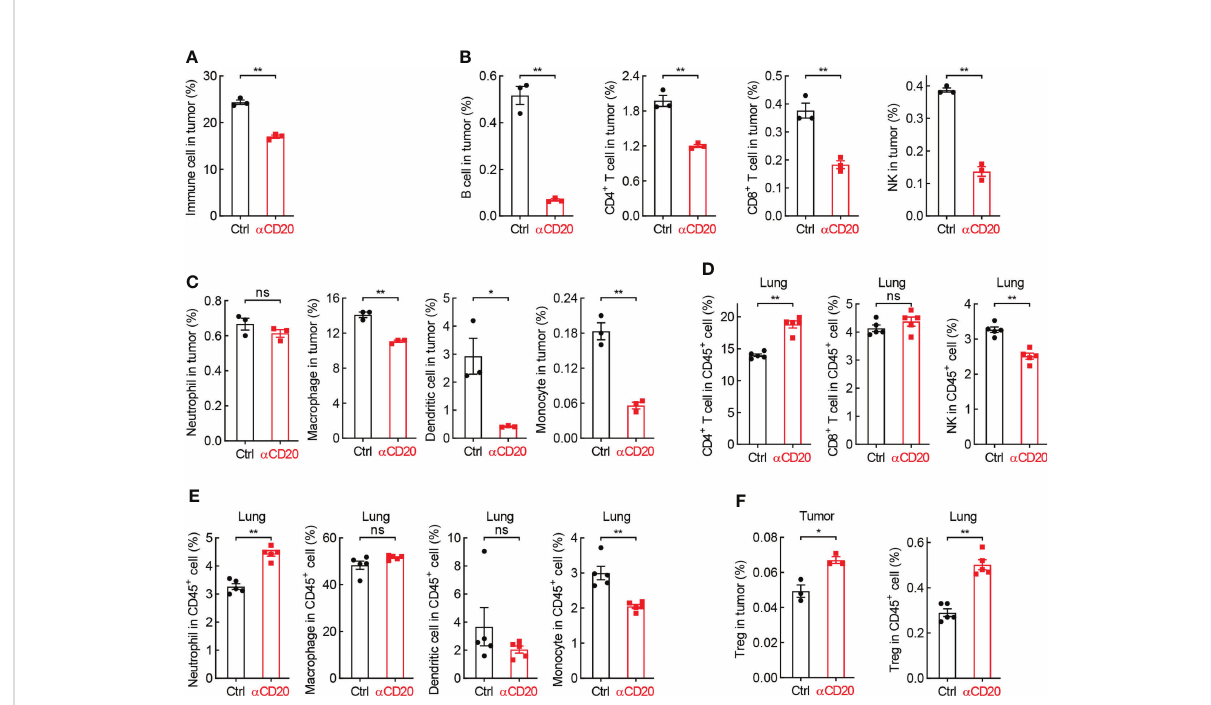
FIGURE 5 B cell deprivation dampens tumor in fi ltration of immune cells in lung cancer. (A) FACS data showing reduced abundance of immune cells in tumor from mice with a CD20-mediated B cell depletion (n = 3). (B, C) FACS data showing decreased tumor-in fi ltrating lymphocytes (B) and myeloid cells (C) by a CD20-mediated B cell depletion (n = 3). (D, E) FACS data showing differential changes of lymphocytes (D) and myeloid cells (E) in lung tissue by a CD20-mediated B cell depletion (n = 5). (F) FACS data showing augmented Treg cell frequency in both lung tumor (n = 3) and lung tissue (n = 5) by a CD20-mediated B cell depletion. Student ’ s t test (two tailed, unpaired) was performed. Data represented means ± SEM. * p < 0.05; ** p < 0.01; ns, not statistically signi fi